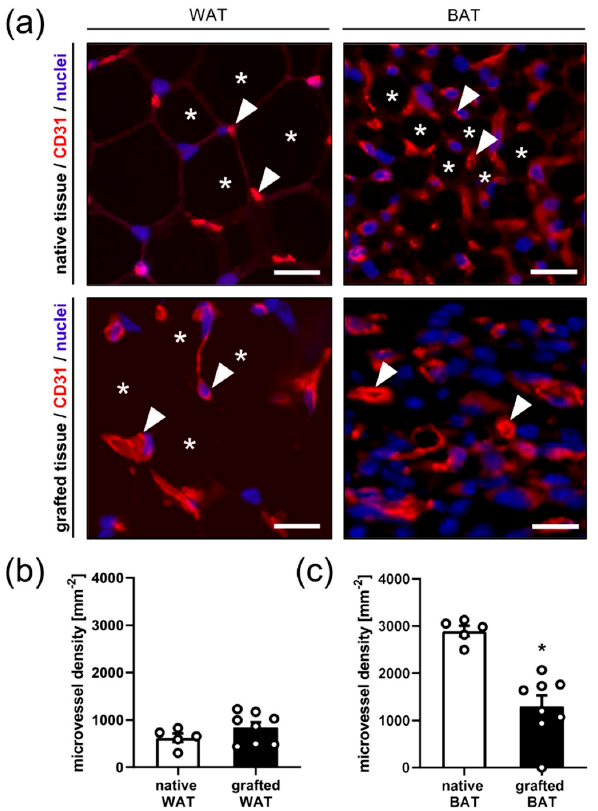
Figure 4. ( a ) Immunofluorescent CD31-stained sections of native WAT and BAT as well as WAT and BAT grafts on day 14 after transplantation. Cell nuclei were stained with Hoechst 33342. Note that native and grafted WAT shows regularly arranged microvessels (arrowheads) between large white adipocytes (asterisks). Native BAT exhibits a regular pattern of small brown adipocytes (asterisks) surrounded by microvessels (arrowheads), whereas grafted BAT consists of a chaotic microvascular network without clearly identifiable brown adipocytes. Scale bars: 20 µ m. ( b , c ) Microvessel density of native tissue (white bars; n = 5) and grafted WAT ( b ); black bar; n = 8) and BAT ( c ); black bar; n = 8) on day 14 after transplantation, as assessed by means of immunohistochemistry. Mean ± SEM; * p < 0.05 vs. native